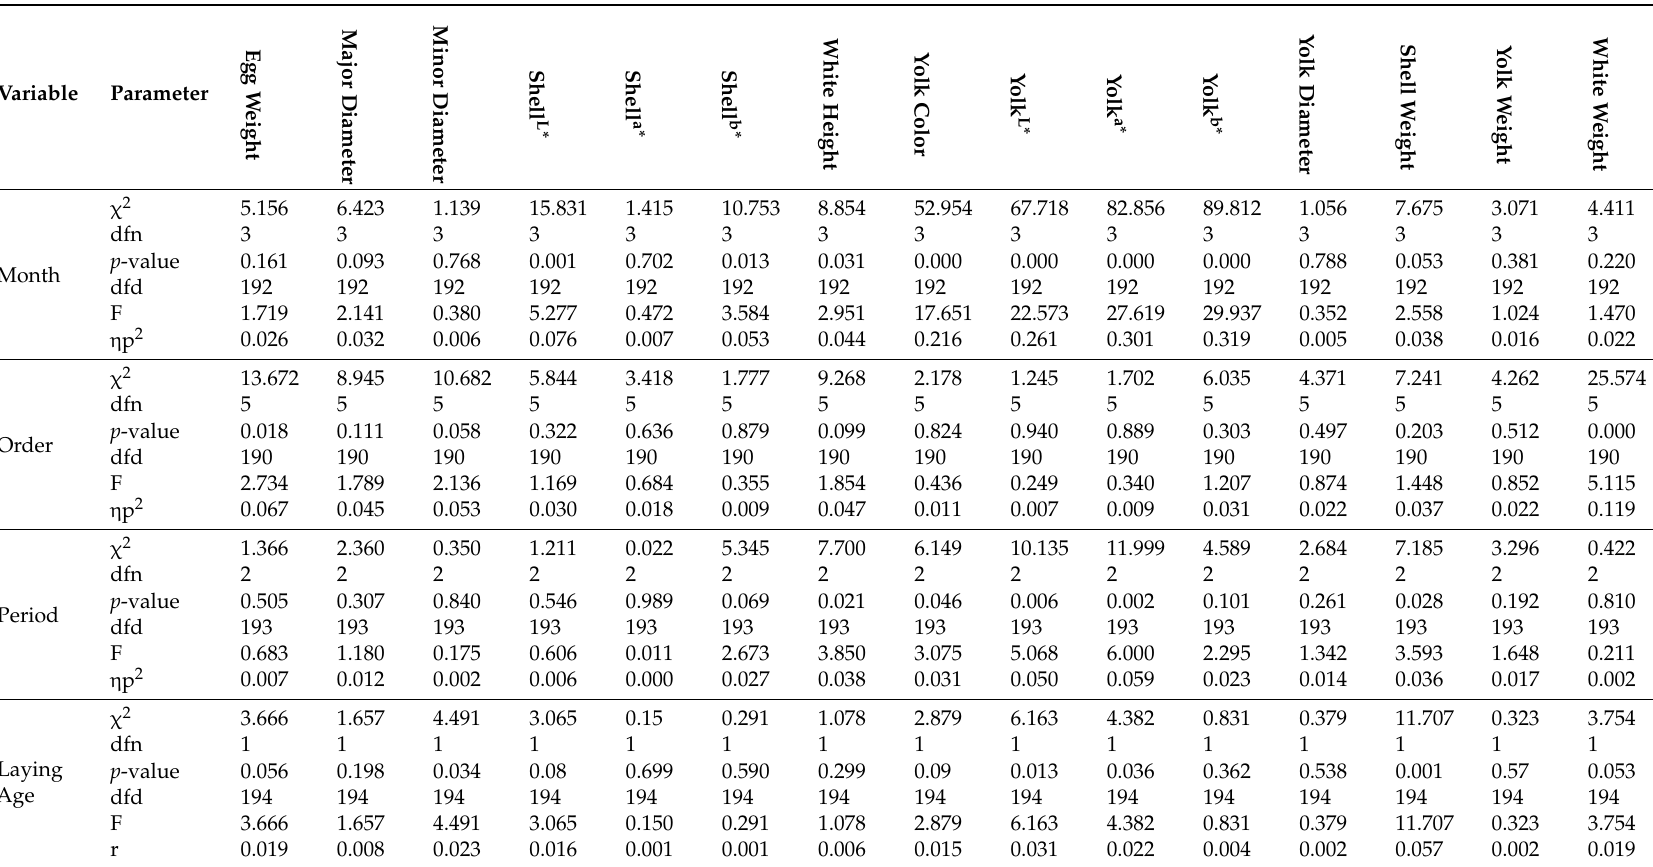
Table 2. Summary of the results for the Kruskal–Wallis H test and the determinative coefficient through r or partial eta squared ( η p 2 ), for the fixed effects for internal and external egg quality traits from the model, excluding yolk and white pH in Utrerana hens (n = 194).